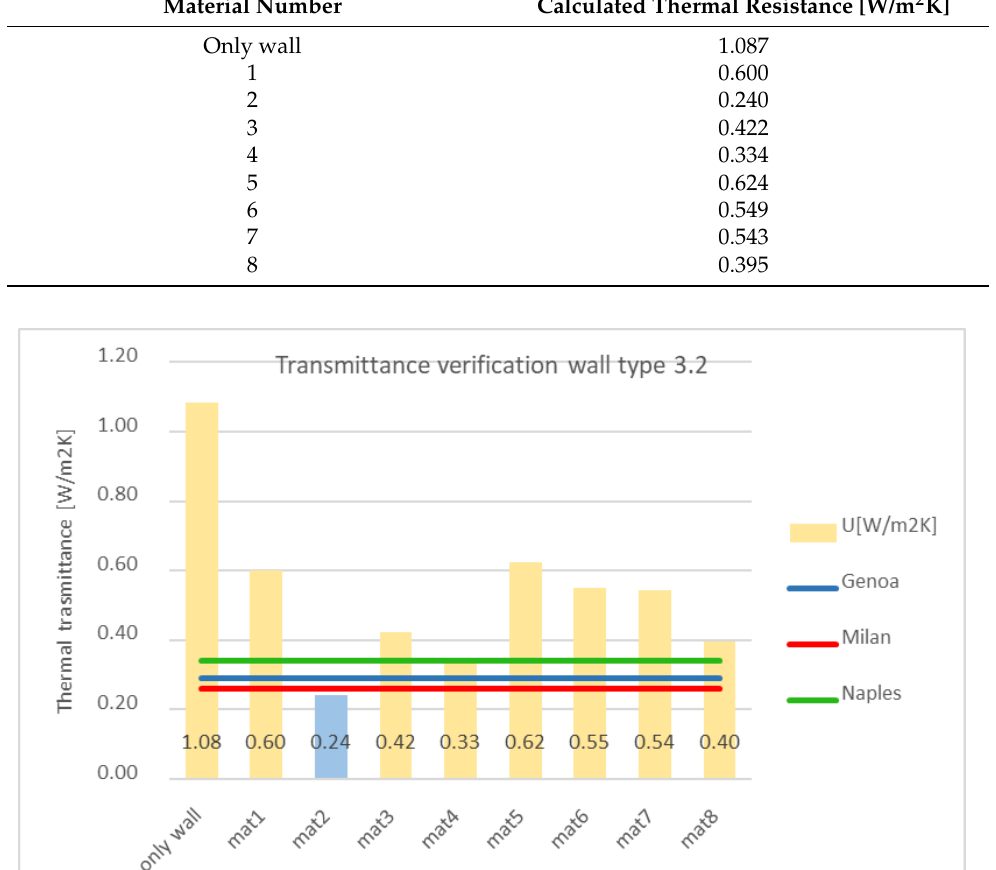
Figure A9. Wall type 3.3: stratigraphy with thicknesses and conductivities for the different layers. The numbers start from the outside.